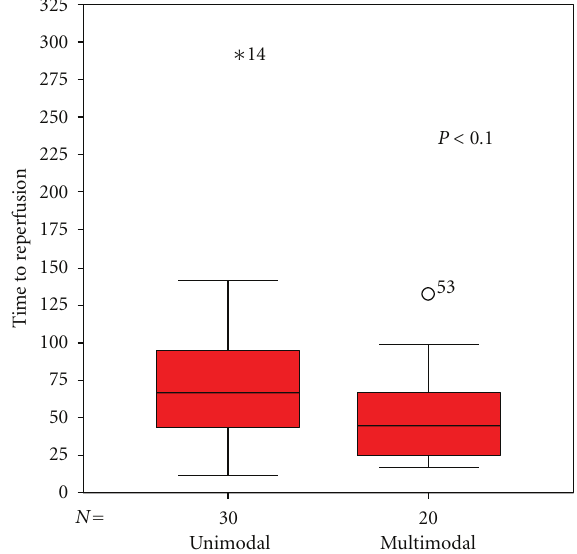
Figure 6: The box plot shows the significant ( P < 0 . 065, Mann- Whitney U ) shorter angio-to-reperfusion times of multimodal procedures compared with unimodal